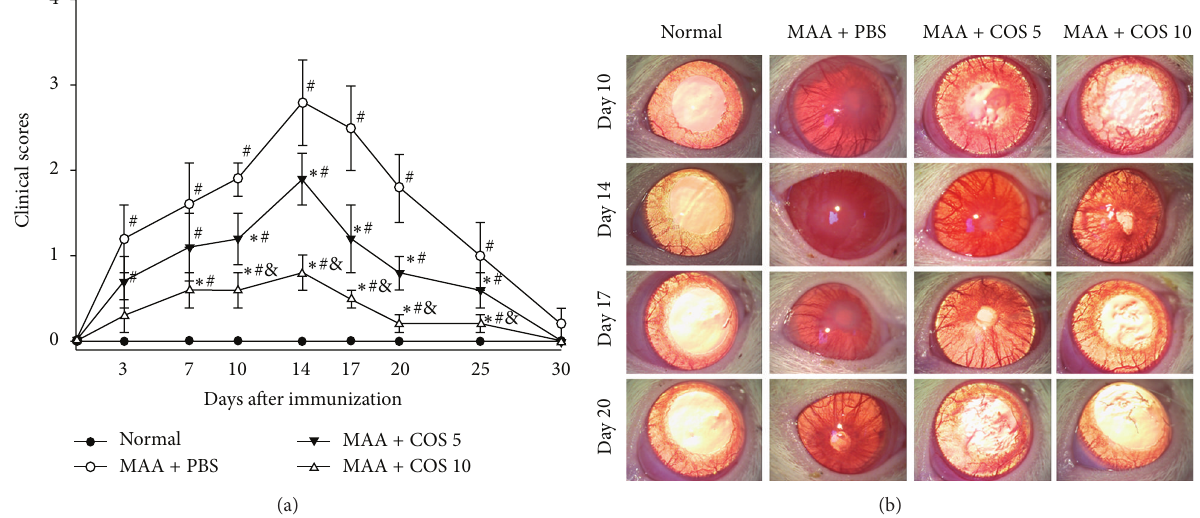
Figure 1: (a) Effects of COS on ocular inflammation demonstrated by clinical scores. The rats in each group were clinically observed on a daily basis using slit lamp biomicroscopy for clinical signs of ocular inflammation. Disease severity was clinically assessed with a scale ranging from 0 to 4. The data are expressed as the mean ± SD ( ∗ 𝑃 < 0.05 compared with the PBS-treated group; # 𝑃 < 0.05 compared with the normal group; & 𝑃 < 0.05 compared with the low-dose group by Kruskal-Wallis 𝐻 test with post hoc Dunn test; 𝑛 = 10 for each group). (b) Representative clinical photographs of the four groups at days 10, 14, 17, and 20 are